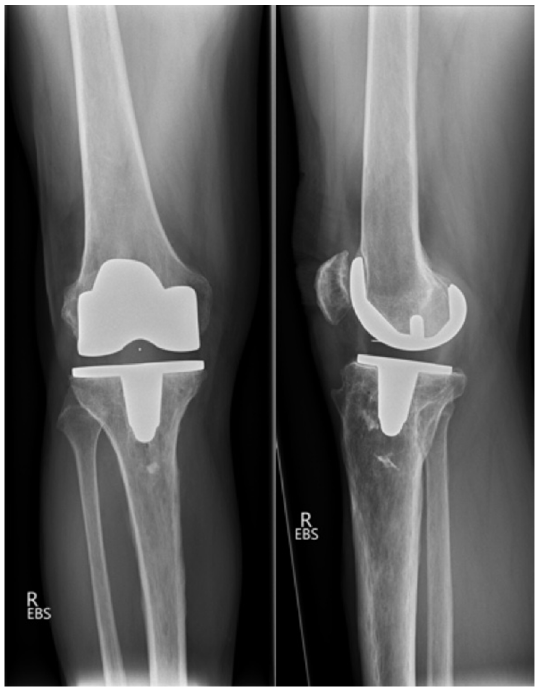
Figure 1. Anteroposterior and lateral non-weight bearing radiographs of the right knee after primary posterior cruciate retaining TKA.